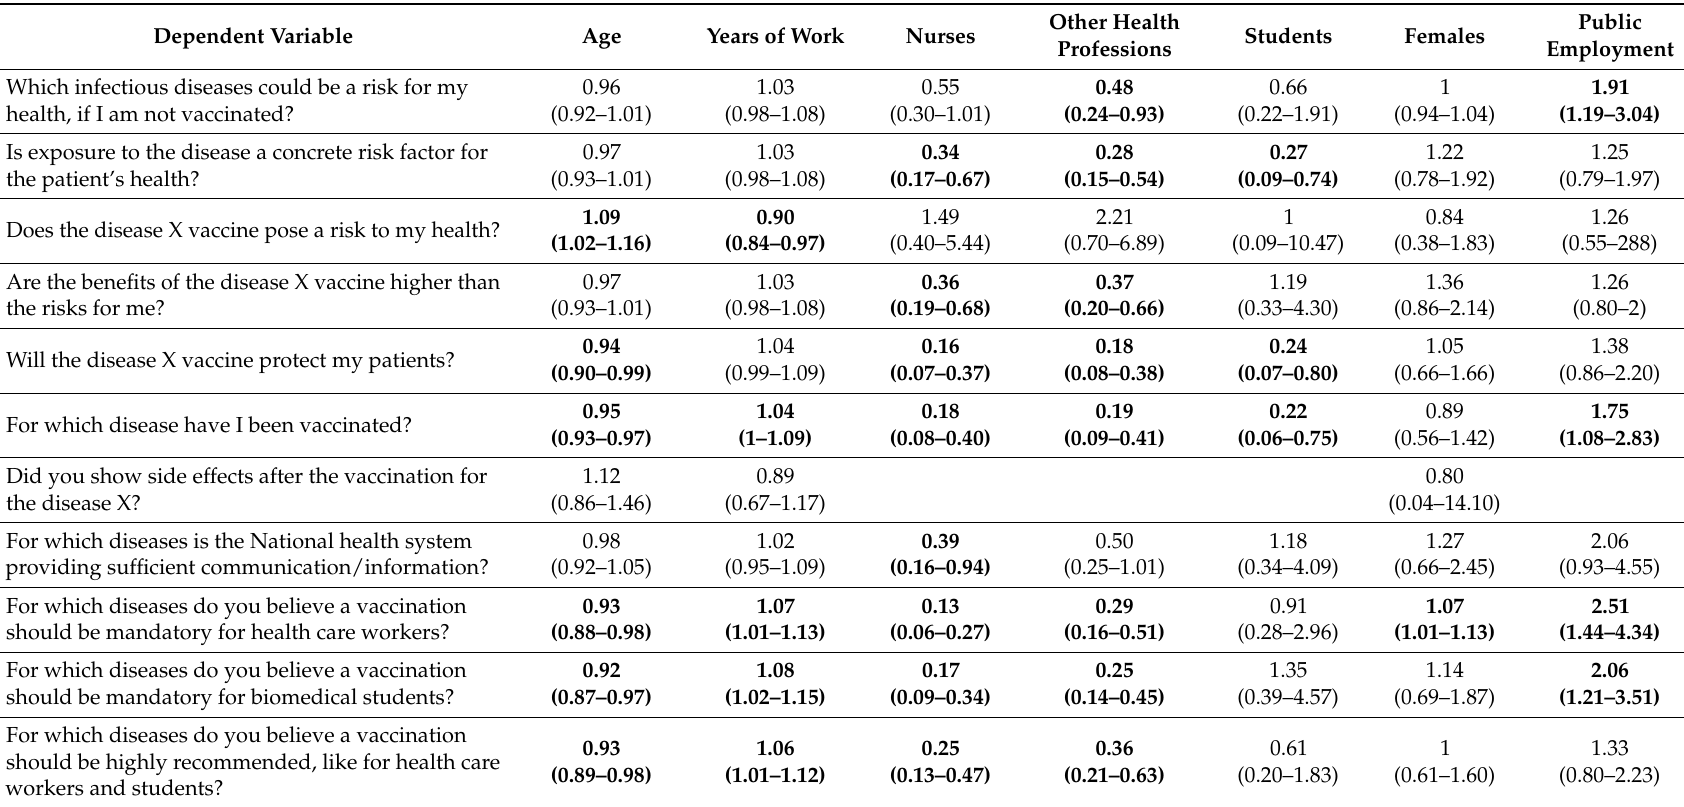
Table 4. Results of the multivariate analysis considering